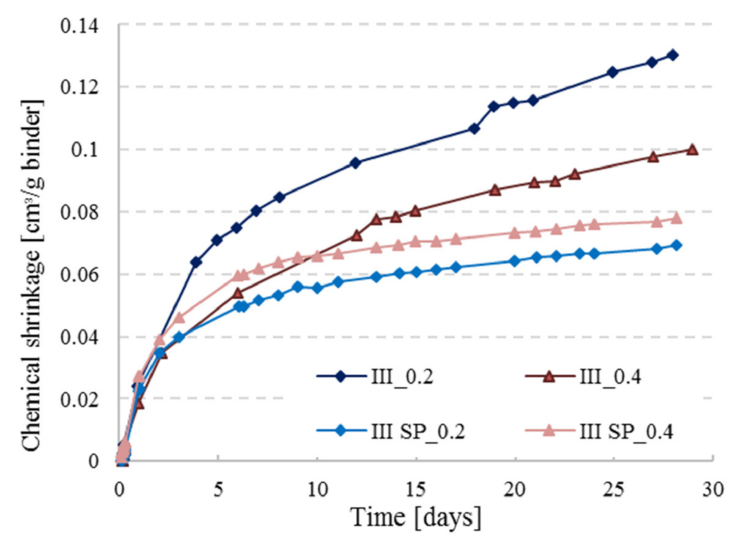
Figure 5. Chemical shrinkage behavior of CEM III pastes with and without superplasticizer at w/c = 0.2 and 0.4.